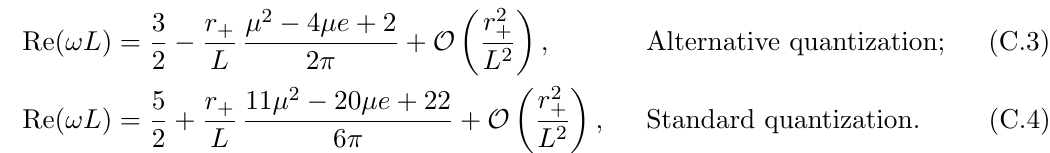
and charges qL = 1 : 9 2